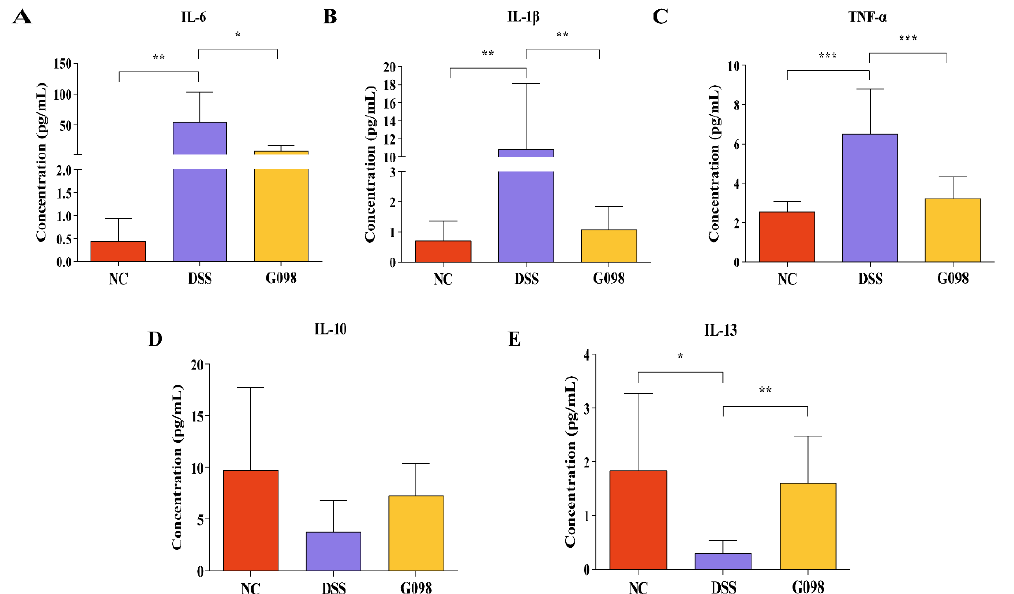
Figure 3. Differences in serum cytokine levels in normal control (NC), dextran sodium sulfate (DSS)- induced, and Lactobacillus gasseri G098 (G098) groups. Levels of ( A ) interleukin (IL)-6; ( B ) IL-1β; ( C ) Tumor necrosis factor (TNF)-α; ( D ) IL-10; and ( E ) IL-13. Error bars represent standard deviation of the mean. Tukey’s multiple comparison tests were used to evaluate differences between groups (*, p < 0.05; **, p < 0.01; ***, p < 0.001).